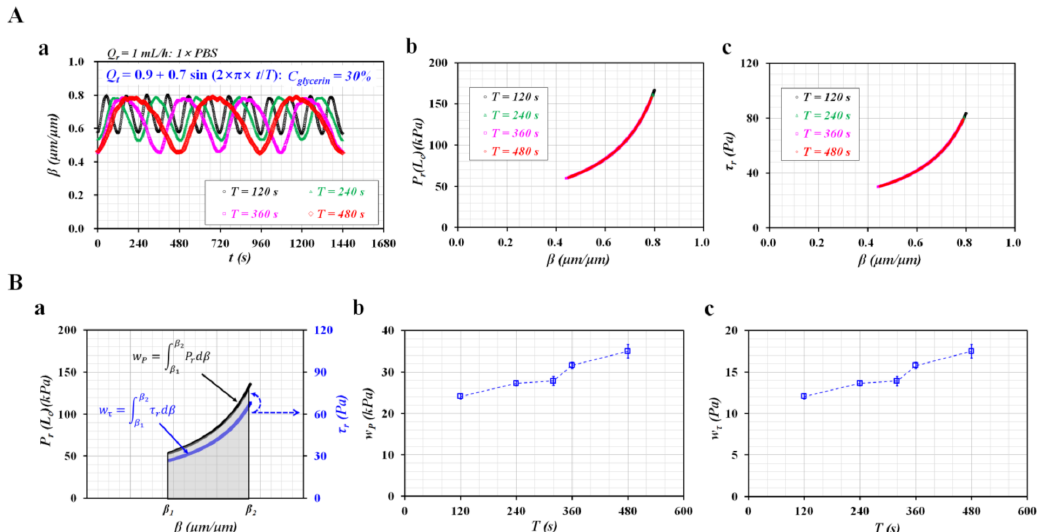
Figure 5. Quantitative evaluations of four parameters (i.e., pressure, shear stress, pressure-unit volume work, and shear stress-unit volume work) under the sinusoidal fluid flow of test fluid. 1 × PBS as reference fluid was sup- plied at the flow rate of 1 mL/h. Glycerin solution ( C glycerin = 30%) as test fluid was supplied at the flow rate of Q t = 0.9 + 0.7 sin (2 × π × t / T ) mL/h. ( A ) Variations of P r and τ r with respect to T = 120, 240, 360, and 480 s. (a) Temporal variation of β with respect to T . (b) Variation of P rs (L c ) with respect to T and β . (c) Variations of τ r with respect to T and β . ( B ) Definition of work per unit volume ( w P , and w τ ) obtained from P r and τ r during a single period. (a) Variations of P r ( L c ) and τ r with respect to β . Based on variations of P r and τ r , pressure-unit volume work ( w P ) and shear stress-unit (cid:82) β 2 (cid:82) β 2 P r d β and w τ = τ r d β , respectively. (b) Variations of w P with respect to T . volume work ( w τ ) were calculated as w P = β 1 β 1 (c) Variations of w τ with respect to T